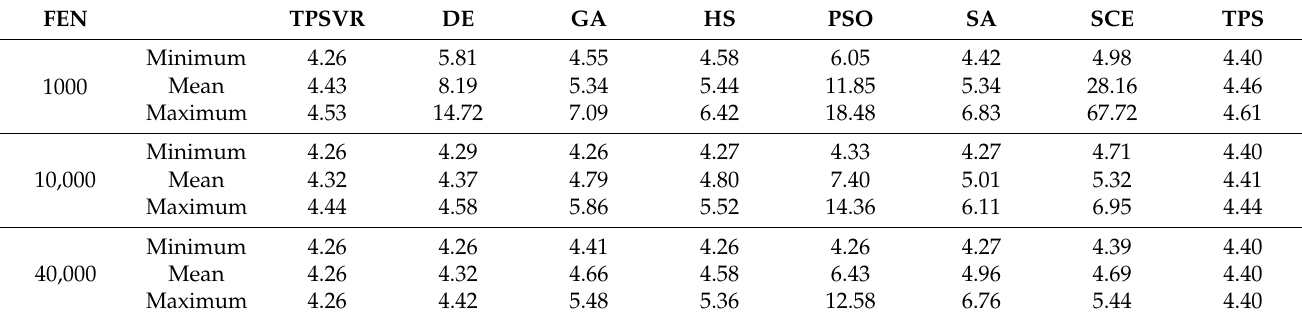
Table 4. Results for the two-loop network.